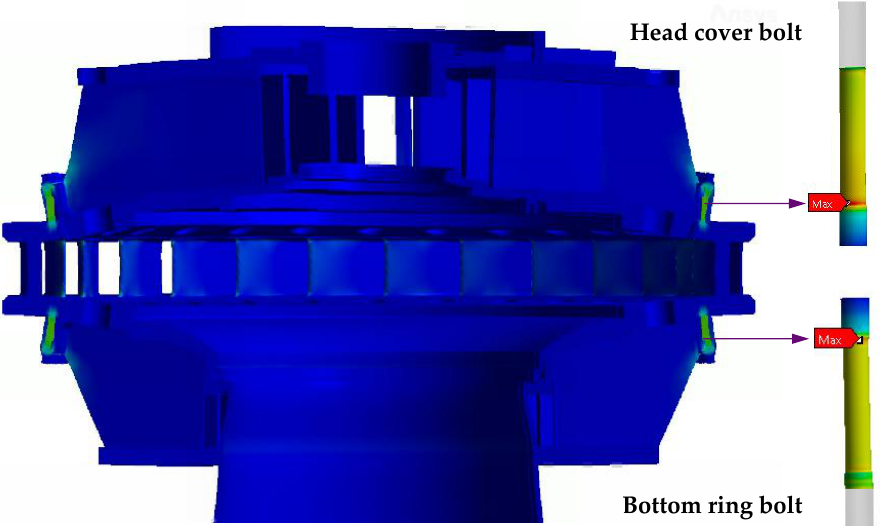
Figure 12. The stress distribution of the structure unit during load